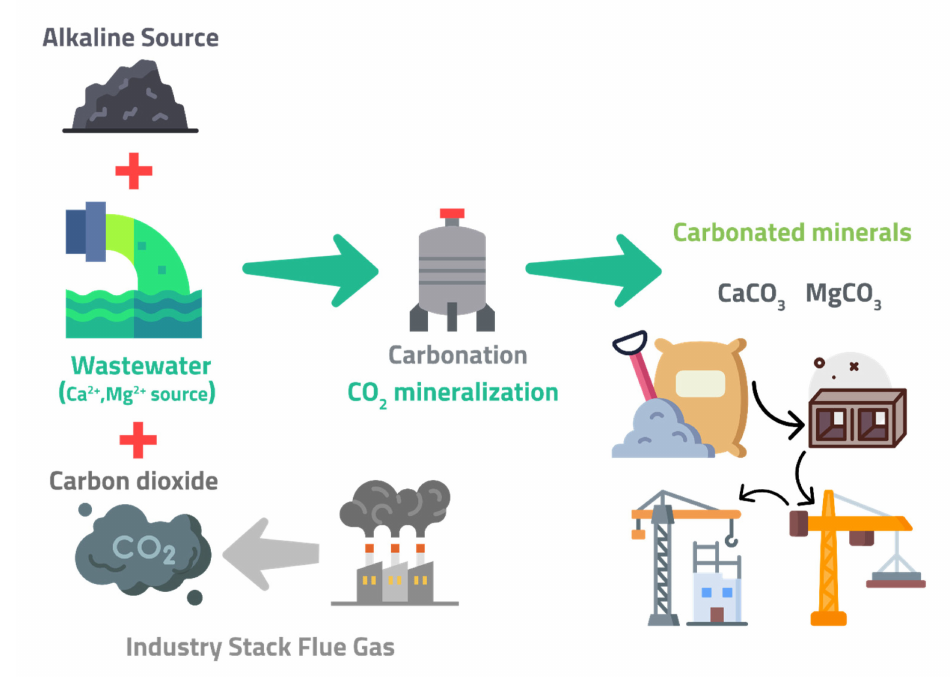
Figure 10. Production of low-carbon CO 2 concrete products from coal combustion residues, flue gas CO 2 , and low-grade waste heat, adapted from Sant